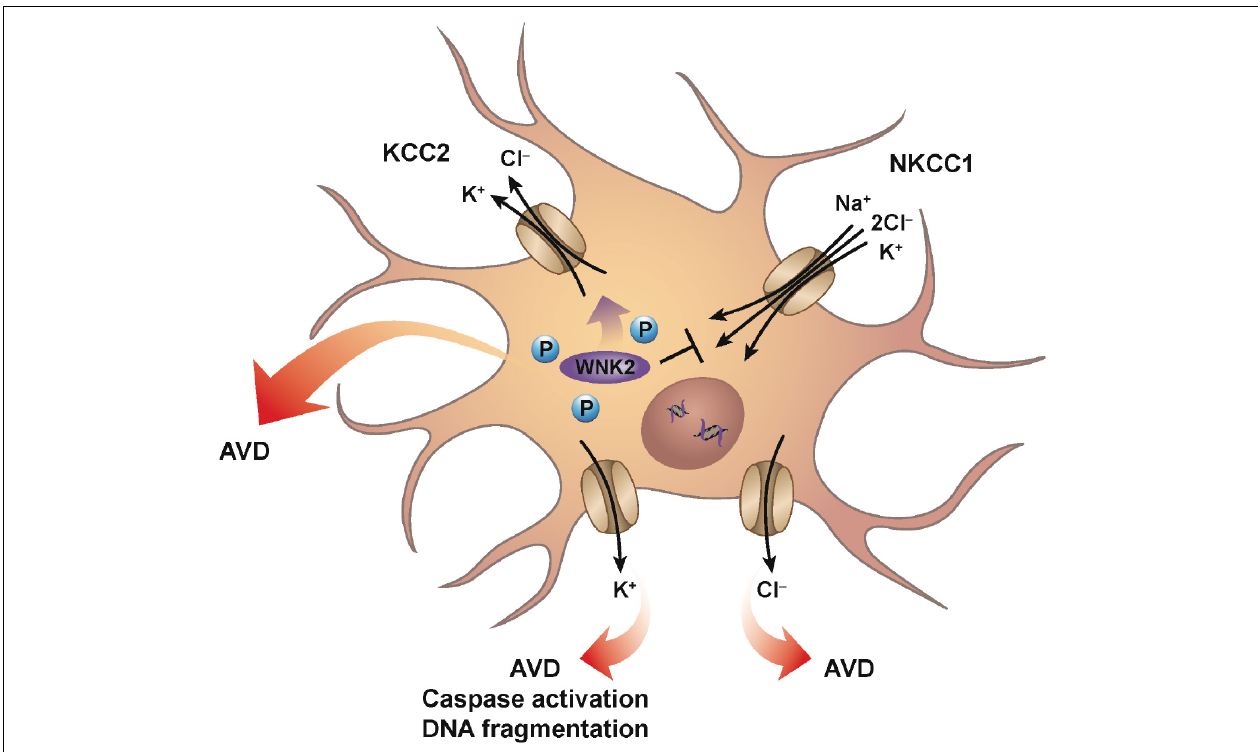
FIGURE 1 | Neuronal AVD. Mechanisms similar for classical RVD are engaged during neuronal AVD. Ionic cotransporters and cotransporters, mainly involving the flux of chloride are activated to counter the imbalance of intracellular water due to hypotonic conditions. For example, conventional ionic transport mechanisms such as NKCC1 and KCC2 are oppositely-regulated via serine–threonine phosphorylation such that dephosphorylation results in the inhibition of NKCC1, while simultaneously activating KCC2. The net result is the loss of both intracellular potassium and chloride with the parallel decrease in water. Additionally, individual potassium and chloride channels have also been shown to have a role during neuronal AVD. Interestingly, potassium channel activation was shown to result in AVD, caspase activation, and DNA fragmentation, while chloride channel activation resulted in only